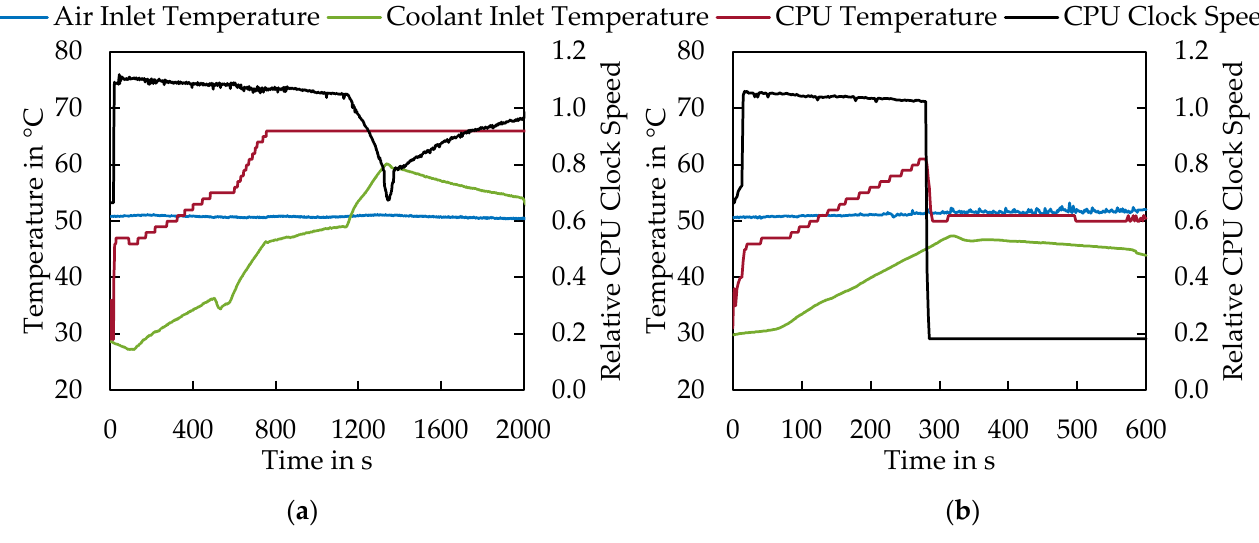
Figure 3. Thermal testing of the DPU at 50 °C test chamber temperature: ( a ) with case fans; ( b ) without case fans.